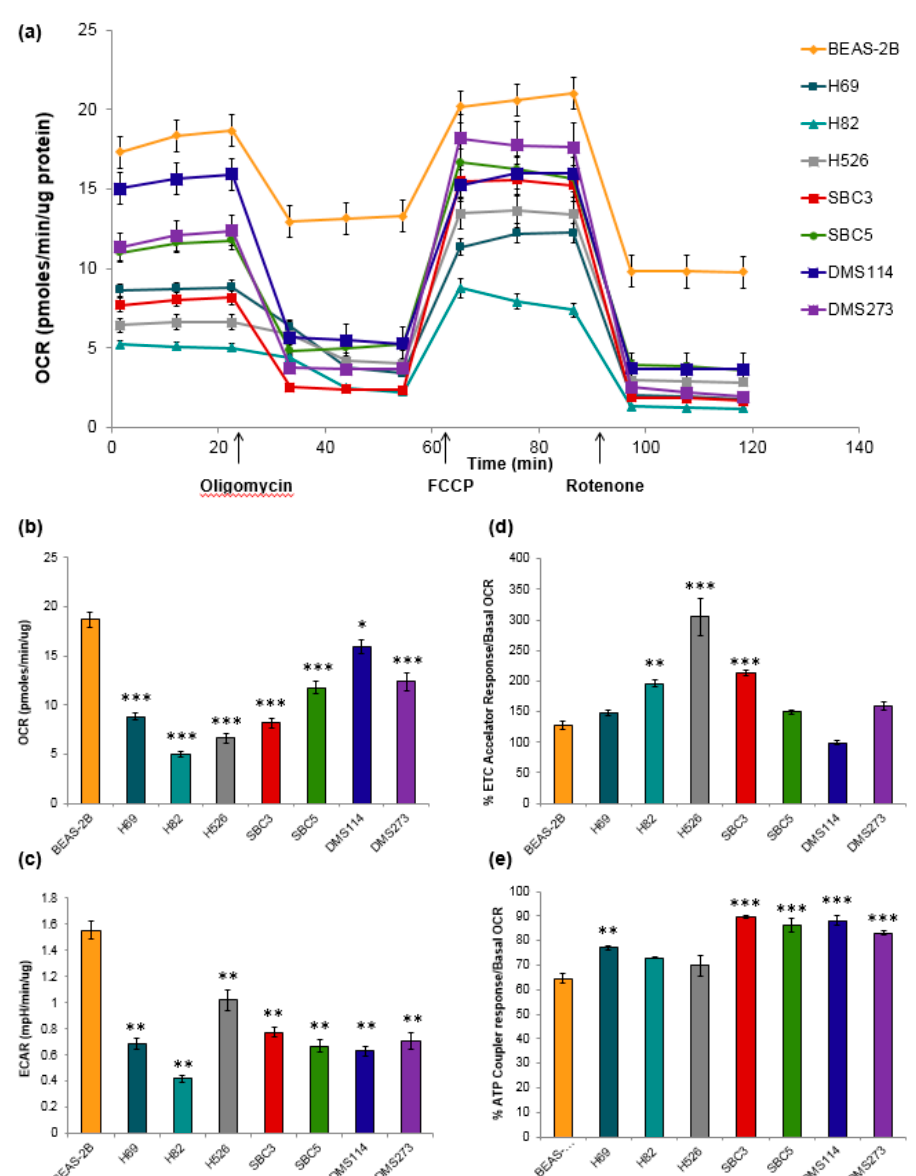
Figure 4. Mitochondrial oxidative and glycolytic activity in SCLC cell lines. Spare respiratory capacity indicates how close a cell operates to its bioenergetic limit. The mitochondrial stress test was used to obtain the bioenergetic parameters. ( a ) An example of one mitochondrial stress assay, arrows indicate the addition of 0.5 µ M oligomycin A (oligo), 0.5 µ M FCCP, and 1 µ M rotenone. ( b ) Oxygen consumption rate (OCR), an indicator of mitochondrial oxidative phosphorylation. Basal mitochondrial OCRs in SCLC cells were significantly different compared to BEAS-2B OCR . ( c ) Extracellular acidification rate (ECAR), an indicator of glycolytic activity measured over time using Seahorse extracellular flux analyzer. Basal mitochondrial OCR in SCLC cells were significantly different compare to BEAS-2B. ( d ). Three SCLC cell lines (H82, H526, and SBC3) had significantly